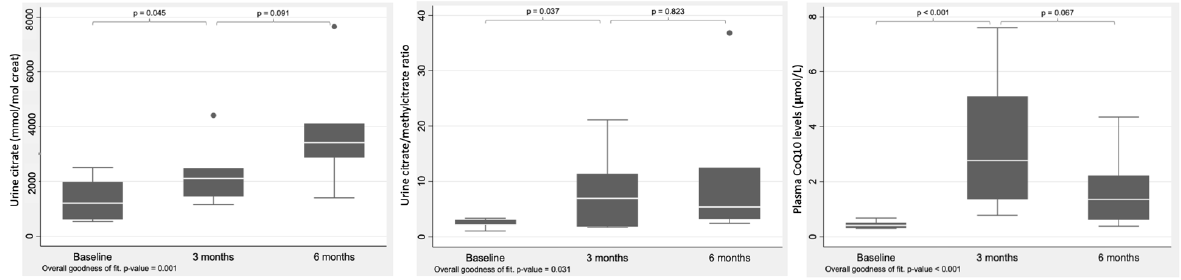
Figure 3. Effect of ubiquinol supplementation on plasma CoQ10 (µmol/L), urinary citrate levels (mmol/mol creat), and citrate/methylcitrate ratio.